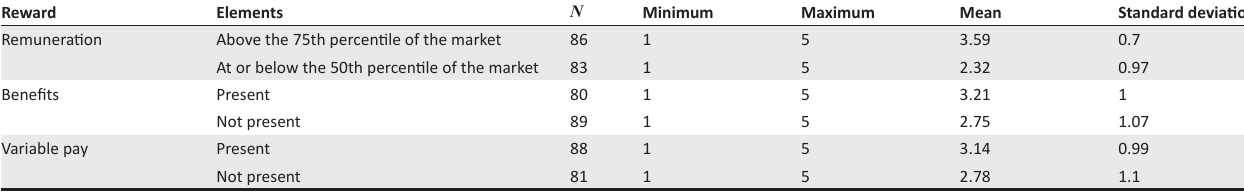
TABLE 4: Descriptive statistics of the manipulated financial reward